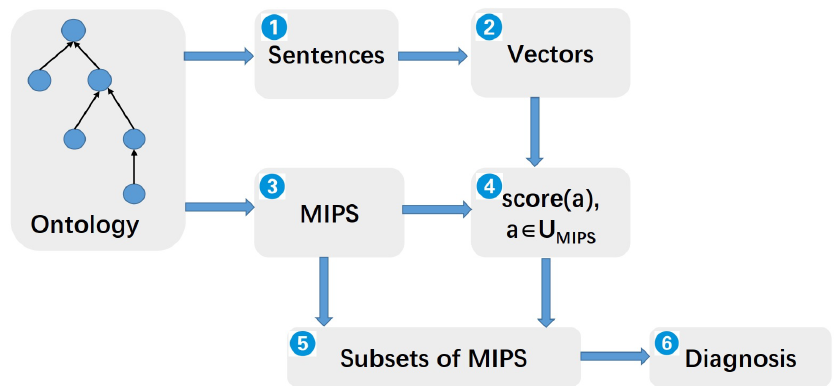
Figure 1. The embedding-based approach to repairing an ontology.